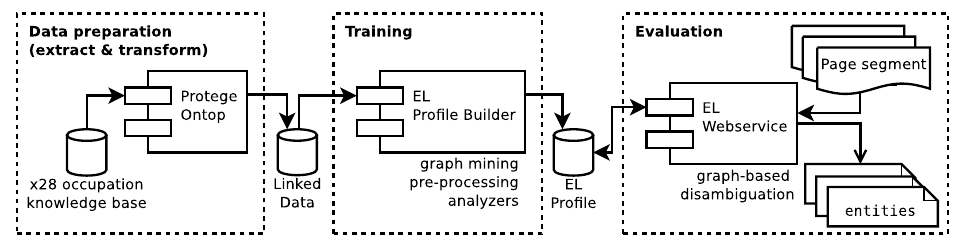
Figure 5. Steps required to prepare a knowledge base for use in the entity linking (EL) compo- nent: data preparation transforms the data into a Linked Data repository, training mines the data repository to create a serializable EL profile, and evaluation uses the profile to annotate new and unknown